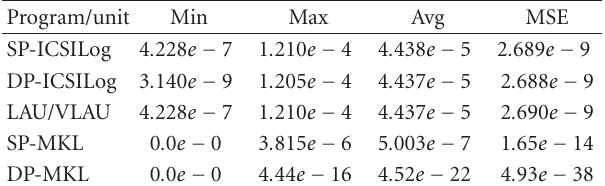
Table 3: Min, max, average, and mean squared error of logarithm implementations with respect to GNU